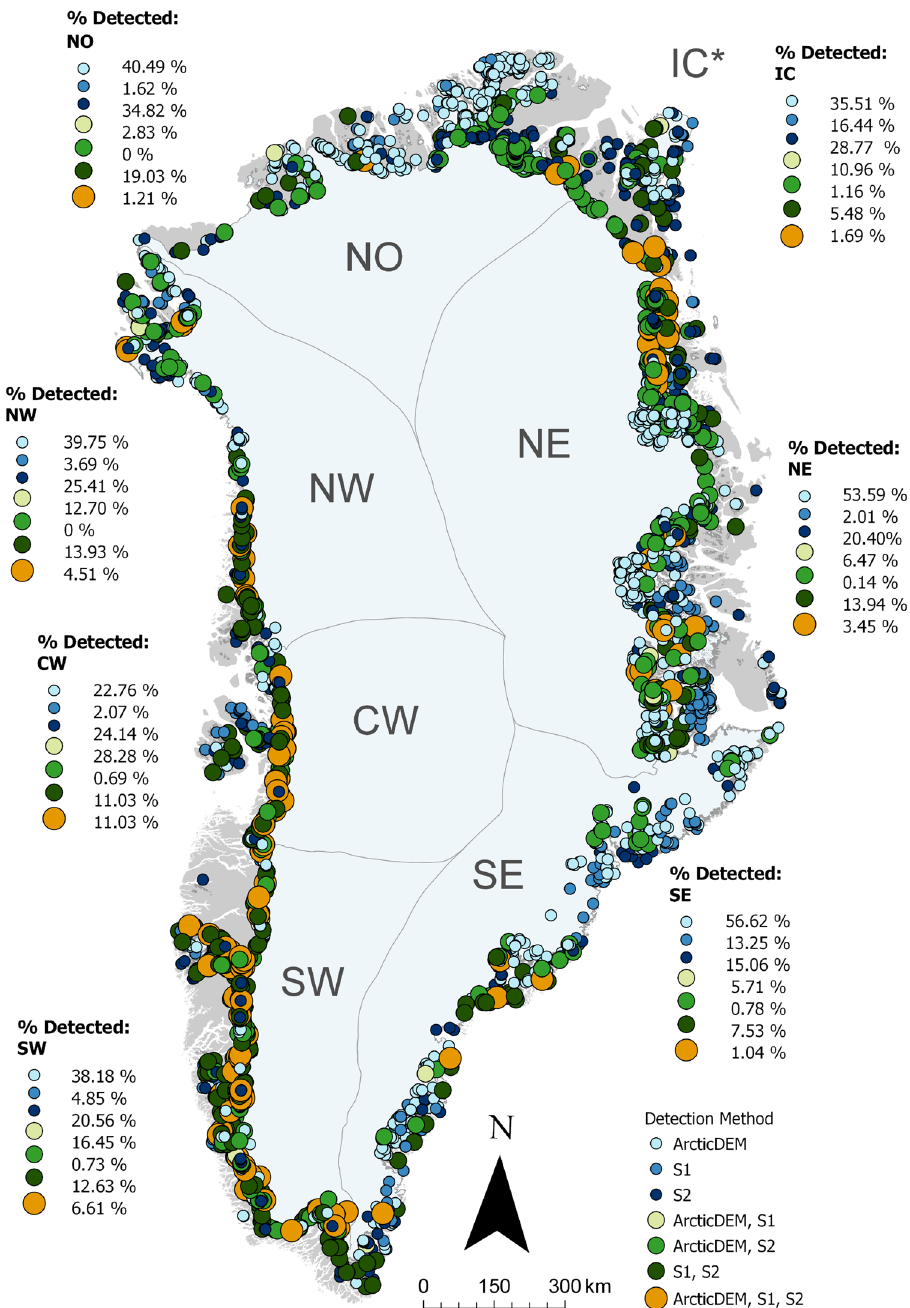
Figure 4. The number of detection methods that successfully classified each ice marginal lake, split by region with percentage breakdowns of each combination of detection methods (see Table S1 for further details). Ice sheet basins are based on those classified as ice catchments by Mouginot and Rignot 32 . Figure generated with ArcGIS Pro (v2.6.1, https ://www.esri.com/en-us/arcgi s/produ cts/arcgi s-pro/) 66 . *IC denotes ice marginal lakes found at the margins of Greenland’s ice caps and mountain